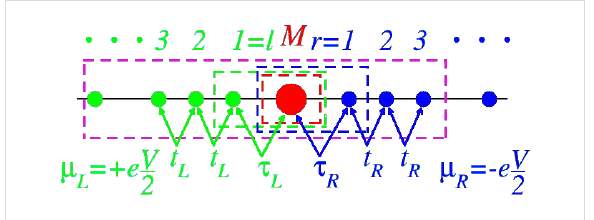
Figure 1: Schematic representation of molecular transport in a two-ter- minal setup consisting of a molecule (M) coupled to left ( L → l = 1,2,3,…) and right ( R → r = 1,2,3,…) electrodes under an applied bias V . In an adequate transport treatment, the current should be independent of how the system is partitioned, i.e., on how large the extended molecule (depicted by dashed rectangles) is.